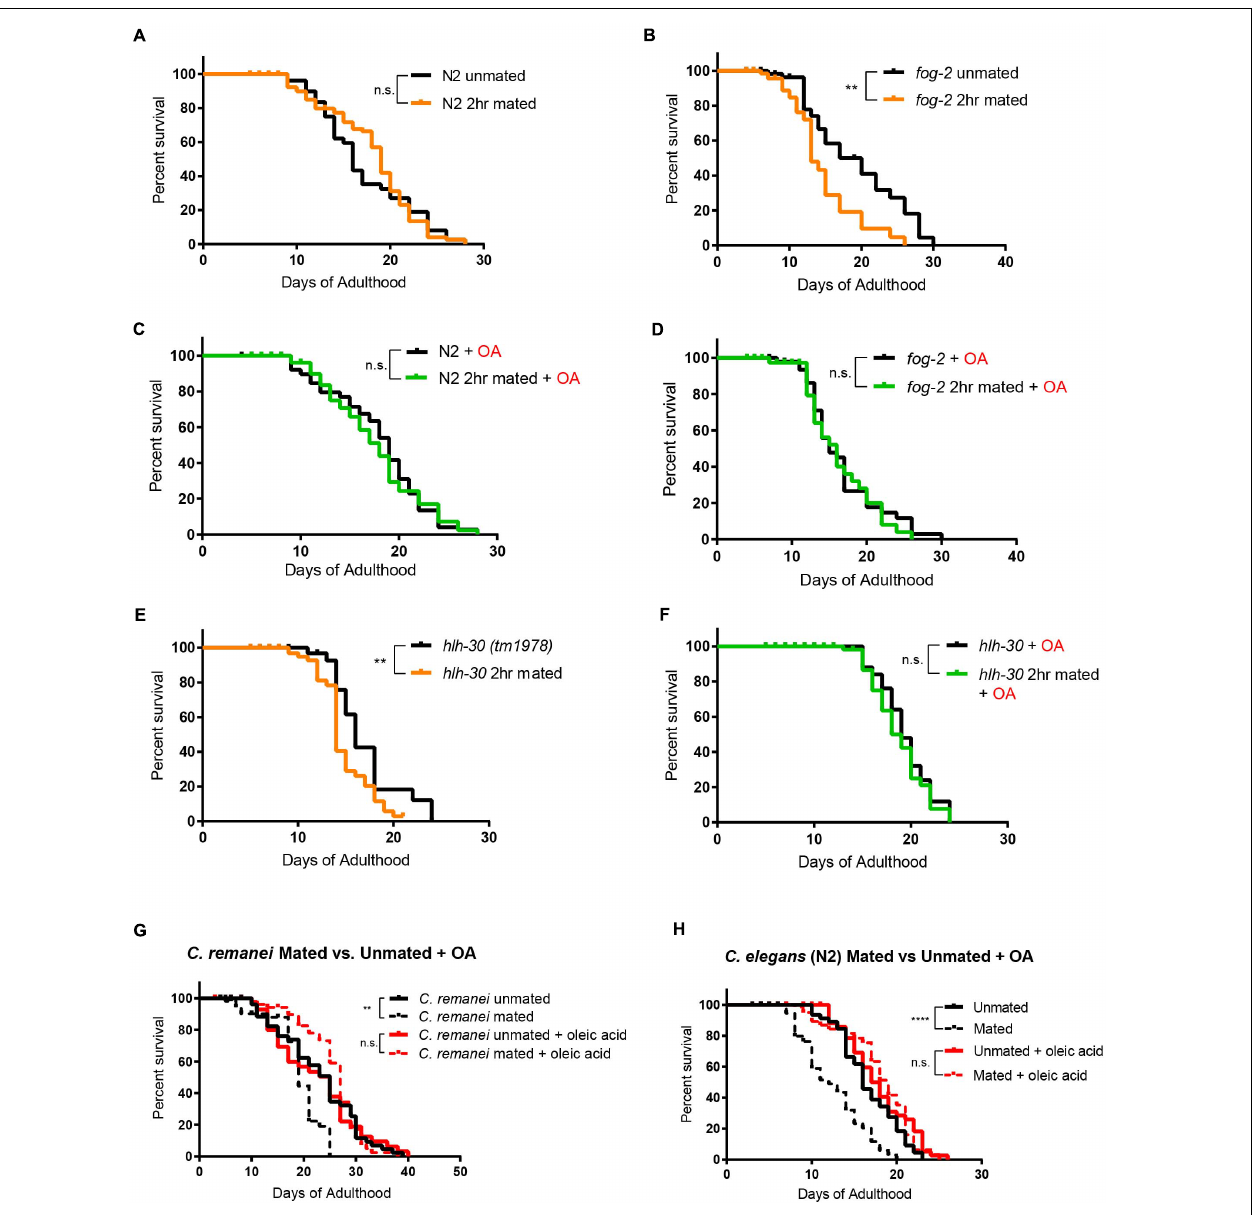
FIGURE 4 | Oleic acid-specific mating-induced death rescue is conserved. Kaplan-Meier analysis with log-rank (Mantel-Cox) test was used to determine statistical significance for all the lifespan assays (lifespan of mated worms was always compared to unmated worms of the same genotype/treatment). ** p < 0.01, **** p < 0.0001. (A–F) Oleic acid protects worms from short-term mating-induced death. (A) Unmated N2: 16.7 ± 0.8 days, n = 60; 2 h mated: 17.8 ± 0.5 days, n = 100, p = 0.5900. (B) Unmated fog-2 : 18.2 ± 1.4 days, n = 60; fog-2 2 h mated: 14.0 ± 1.0 days, n = 100, p = 0.0044. (C) Unmated N2 + oleic acid: 17.4 ± 0.7 days, n = 60; 2 h mated + oleic acid: 17.7 ± 0.6 days, n = 100, p = 0.7676. (D) Unmated fog-2 + oleic acid: 16.4 ± 0.8 days, n = 60; fog-2 2 h mated + oleic acid: 16.2 ± 0.9 days, n = 100, p = 0.5910. (E) Unmated hlh-30 : 16.6 days ± 0.8 days, n = 60; hlh-30 2 h mated: 14.3 ± 0.4 days, n = 100, p = 0.0117. (F) Unmated hlh-30 + oleic acid: 19.4 ± 0.5 days, n = 60; hlh-30 2 h mated + oleic acid: 18.8 ± 0.4 days, n = 100, p = 0.4357. (G) Mated C. remanei mothers’ lifespans are also rescued by oleic acid supplementation. Unmated: 22.6 ± 1.2 days, n = 60; mated: 18.2 ± 0.8 days, n = 60, p = 0.0029; unmated + oleic acid: 21.9 ± 1.4 days, n = 60; mated + oleic acid: 25.3 ± 0.9 days, n = 60, p = 0.3266. (H) Lifespans of unmated and mated N2 hermaphrodites with and without oleic acid supplementation. Unmated: 16.6 ± 0.5 days, n = 49; mated: 11.8 ± 0.5 days, n = 80, p < 0.0001; unmated + oleic acid: 17.9 ± 0.6 days, n = 50; mated + oleic acid: 18.1 ± 0.6 days, n = 80, p =